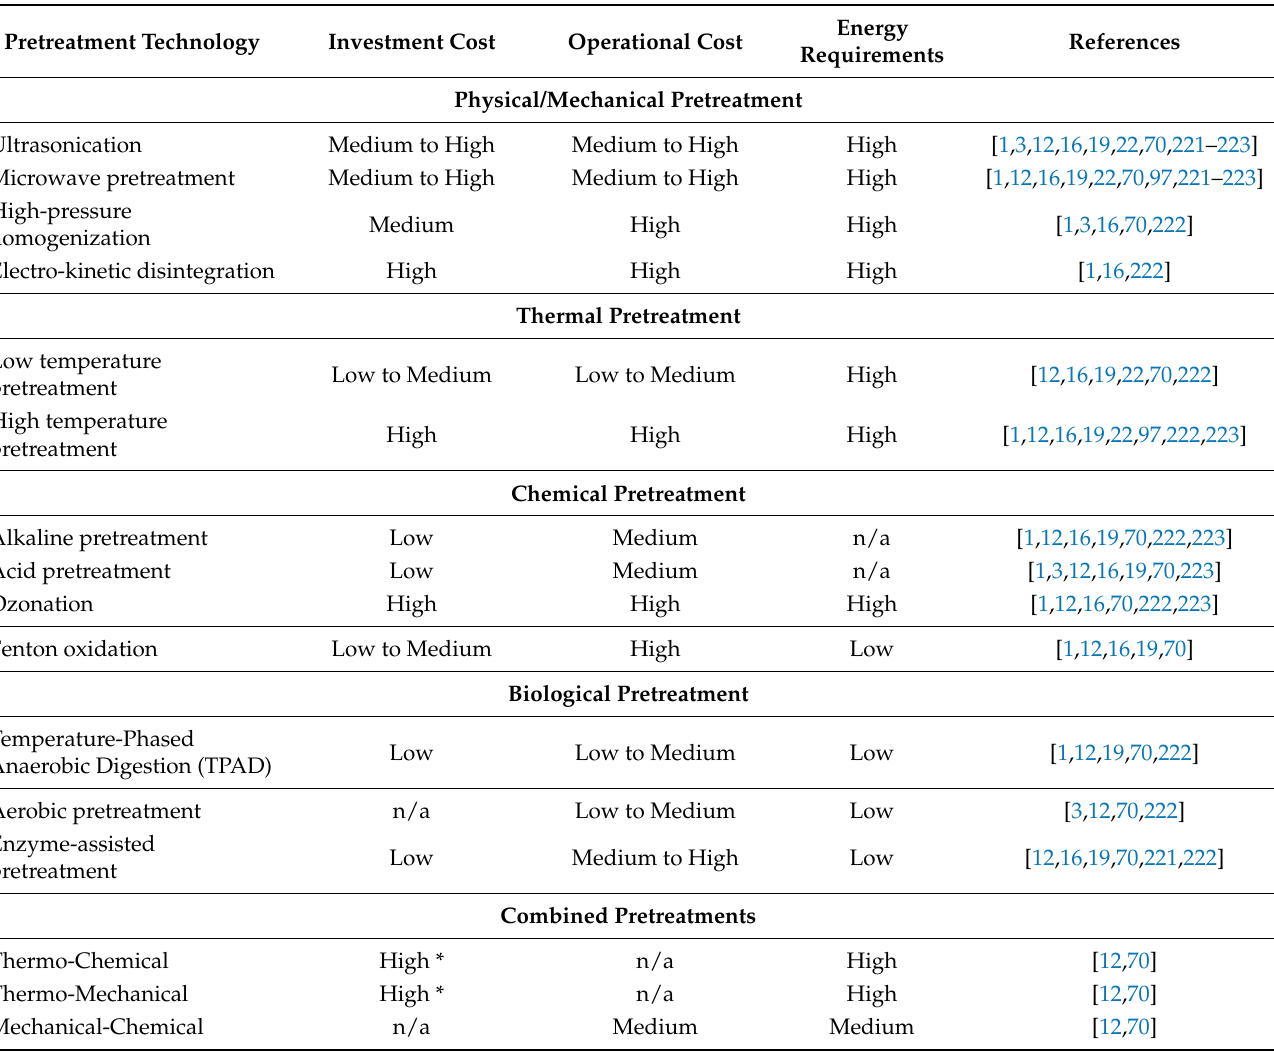
Table 6. Qualitative assessment of the energy requirements and economic feasibility of different sludge pretreatments